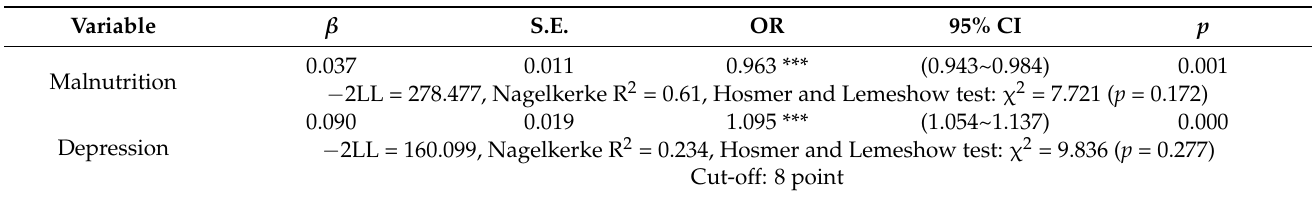
Table 7. Correlations between Dysphagia (EAT-10) and Malnutrition and Depression using Logis- tic